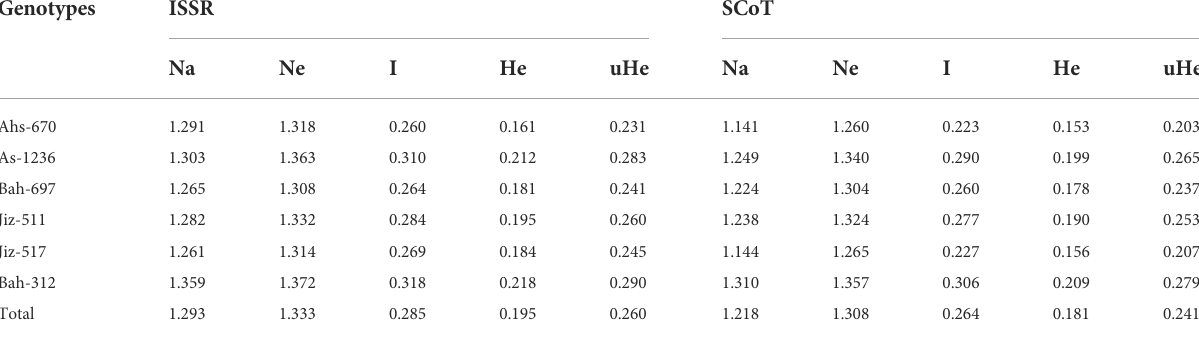
TABLE 6 Genetic parameters for the studied Sesame genotypes using 20 ISSR primers and 25 SCoT primers. Genotypes ISSR